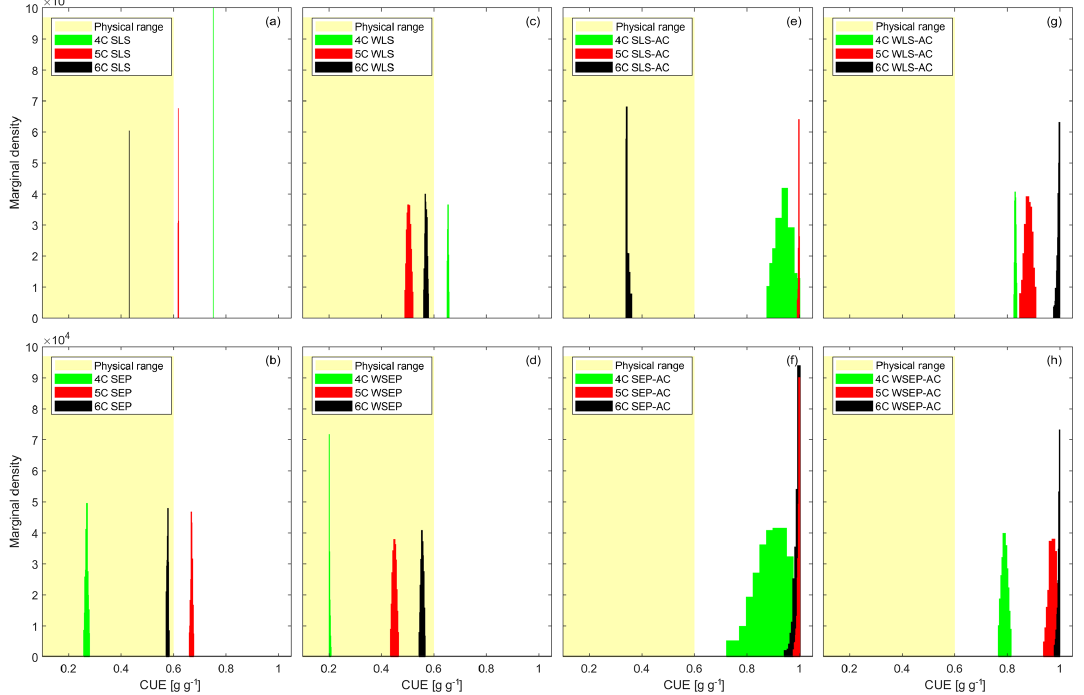
Figure 5. Marginal posterior parameter density of carbon use efficiency (CUE) for the three soil respiration models and eight data models. The yellow shaded areas represent the reasonable physical range of CUE